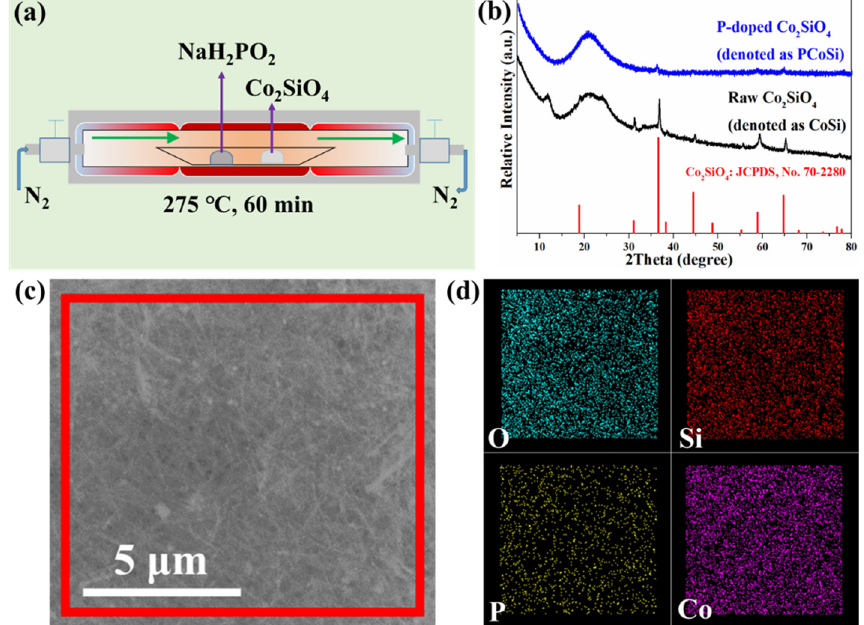
Figure 1. ( a ) Schematical description of the synthetic route of PCoSi; ( b ) XRD patterns of CoSi and PCoSi; ( c ) A SEM image of PCoSi and ( d ) its corresponding elemental mapping images obtained from the red square in ( c ).